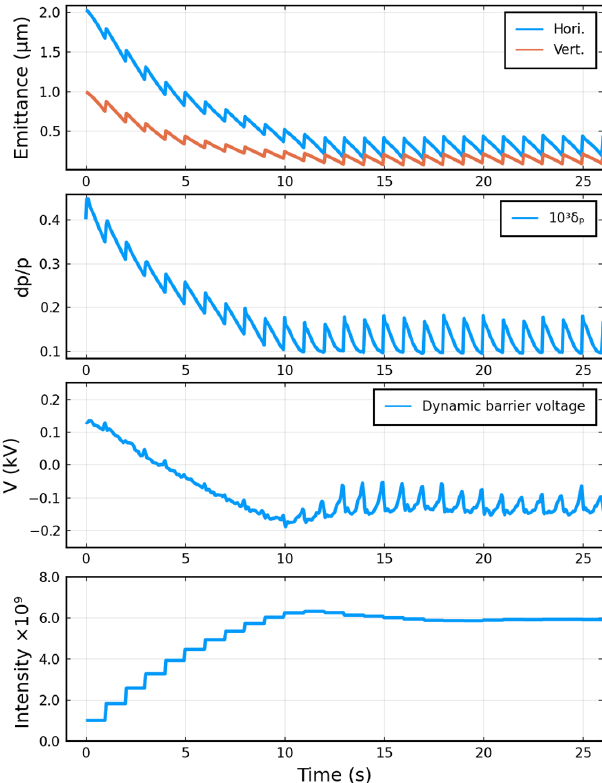
FIG. 6. Evolution of beam emittance and intensity during stacking with an injection interval of 1.0 s.